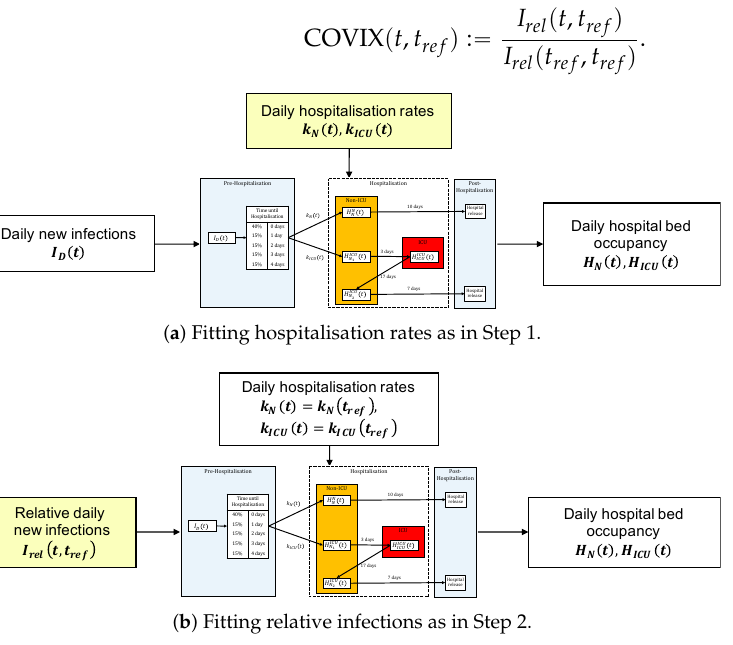
Figure 2. A conceptual comparison of the two quantities fitted in the construction of COVIX. In both ( a , b ), the yellow-coloured quantity is fitted, whereas the white-colored quantities are